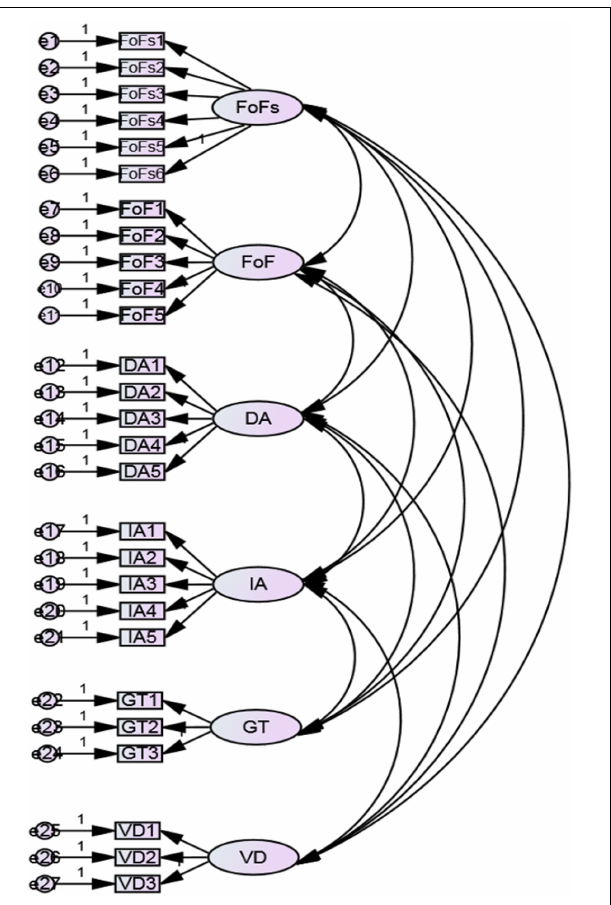
FIGURE 1 | A six-factor model. FoFs , focus on forms instruction; FoF , focus on form instruction; DA , the deductive approach; IA , the inductive approach; GT , the importance of grammatical terminology; VD , the value of drilling.